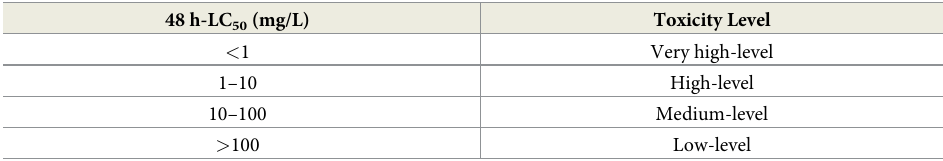
Table 2. Acute toxicity test classification criteria for Daphnia.